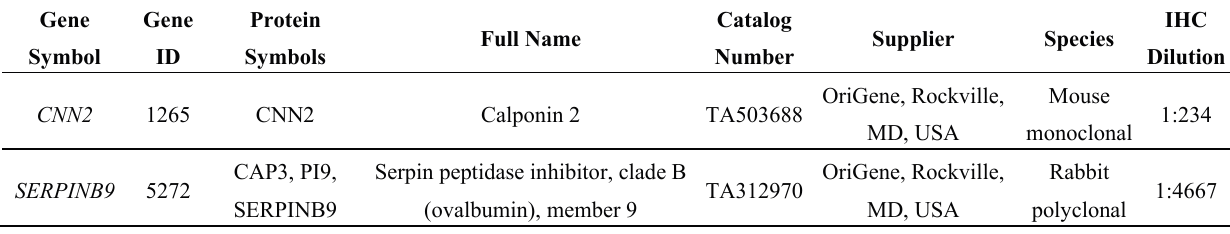
Table 5. Primary antibodies used in immunohistological analyses.